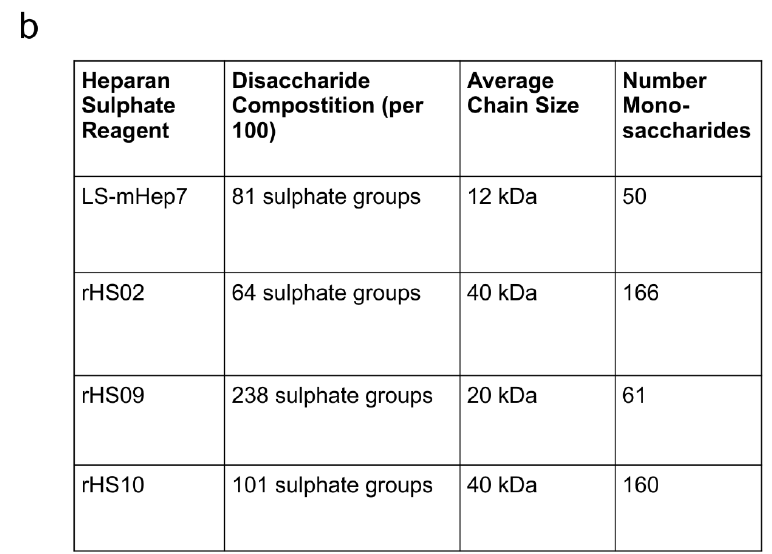
Figure A1. Sulphate content and disaccharide composition of rHS and LS-mHep7. rHS was purified from cultured cells and HS from porcine tissue. The HS and heparin were digested, and disaccharide composition determined by LC/MS previously [19,25]. The abundance of sulphate groups in each position of the polysaccharide was determined from the disaccharide composition data. ( a ) Graph shows the number of sulphate groups per 100 disaccharides present in rHS mimetics and LS-mHep7. rHS10 and LS-mHep7 are both predominantly N -sulphated. rHS09 is highly sulphated containing N -, 2- O -, and 6- O groups. rHS02 has a predominant mixture of no sulphate and N -sulphate. ( b ) Table shows the predominant reagent structure detailing information on approximate disaccharide composition, average chain length and approximate number of monosaccharides.